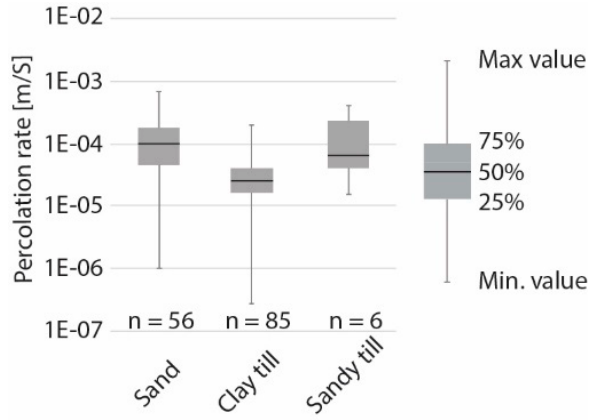
Figure 4. Box plot showing the percolation rates for sand, clay till and sandy till for all investigated areas. N represents the amount of measurements for each soil